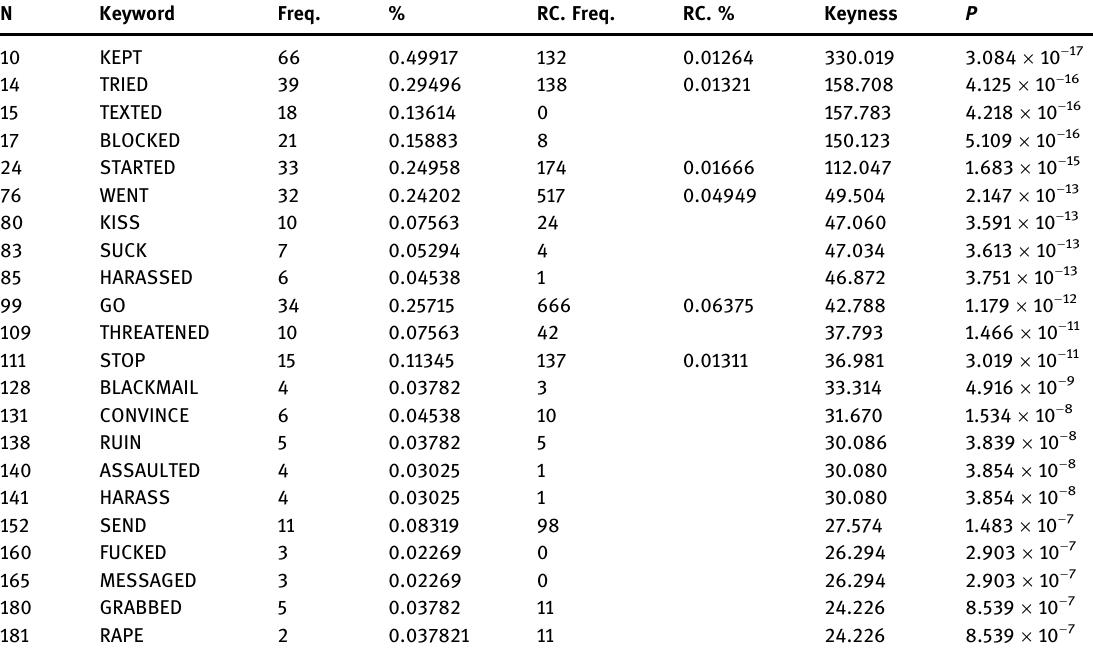
Table 28: Material processes in the keyword list N